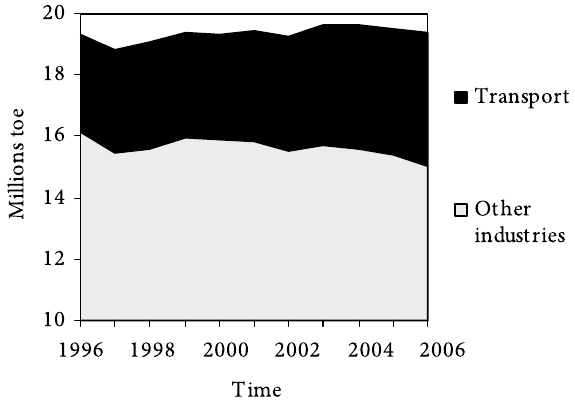
fig. 1. The trends of final consumption LPG in the EU